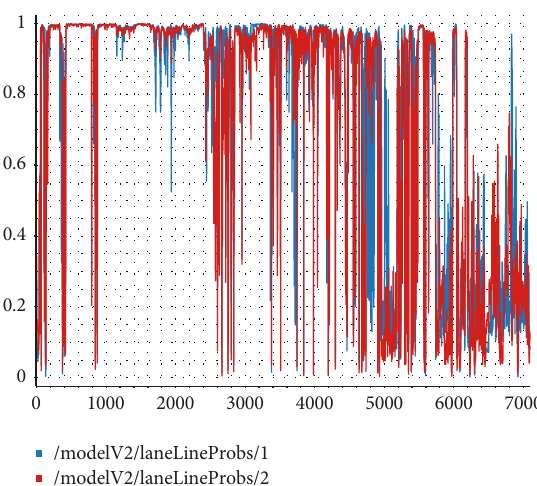
Figure 45: T2D2 left (1) and right (2) lane recognition.